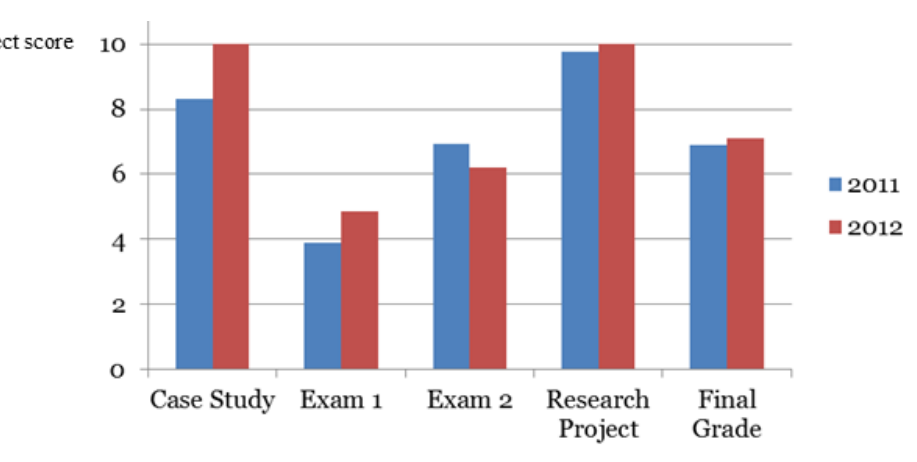
Figure 5. Student grades before and after course redesign.